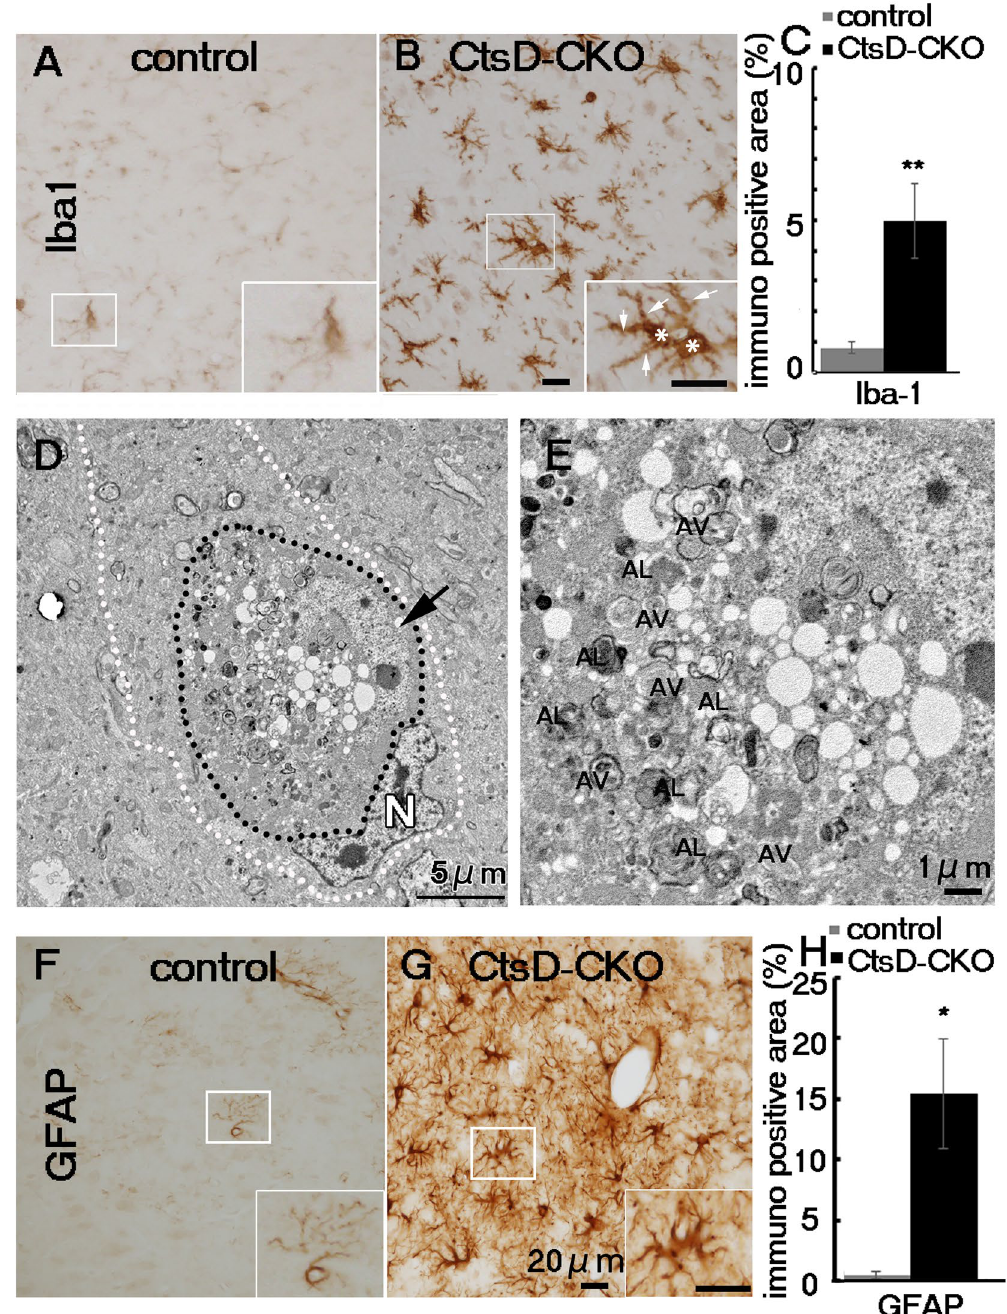
Figure 4. Increase in microglia and astrocyte expression in CtsD-CKO mouse thalamus. Immunohistochemical staining of microglia (Iba1; A , B ) in thalami of CtsD-CKO and control mice at p25. Insets in ( A ) and ( B ) shows a magnified image of the respective boxed area. Arrows indicate thick processes; asterisks indicate expanded round cell bodies. Scale bar: 20 µm. ( C ) Iba1-positive areas in the thalamus of CtsD-CKO mice were compared with age-matched control littermates (**p < 0.03, from p19 to p25 mice, n = three sections form 3 separate mice). ( D ) An electron micrograph of a microglia-like cell (surrounded by white dashed lines) contains a neuron-like cell (surrounded by black dashed lines) with a nucleus (N) and numerous vacuolar structures in the CtsD- CKO thalamus at p25. Arrow, an elongated nucleus of an engulfed neuron. ( E ) A higher magnified image of an engulfed neuron in ( D ). Autophagosome (AV) and autolysosome (AL) like structures were accumulated in the neuron. Immunohistochemical staining of astrocytes (GFAP; F , G ) in thalami of CtsD-CKO and control mice at p25. Insets in ( F ) and ( G ) shows a magnified image of the respective boxed area. Scale bar: 20 µm ( H ) GFAP-positive areas in the thalamus of CtsD-CKO mice were compared with age-matched control littermates (*p < 0.05, from p19 to p25 mice, n = three sections form 3 separate